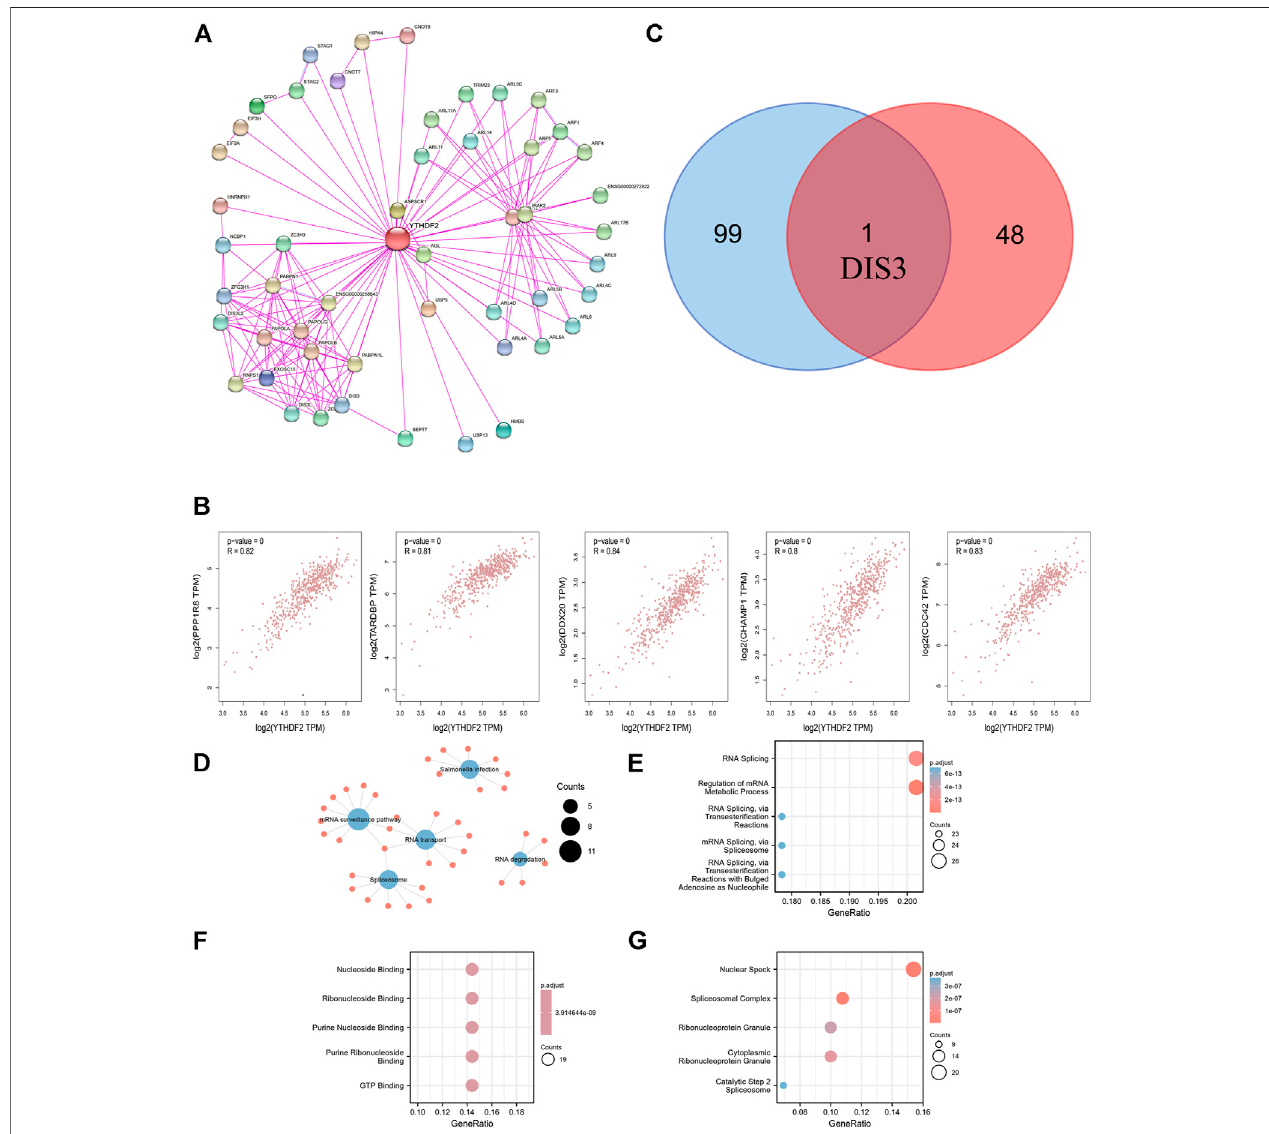
FIGURE 7 | YTHDF2-related gene enrichment analysis and GO and KEGG analysis. (A) The available experimentally determined YTHDF2-binding proteins using the STRING tool. (B) The expression correlation between YTHDF2 and selected targeting genes, including PPP1R8, TARDBP, DDX20, CHAMP1 and CDC42. (C) An intersection analysis of the-binding and correlated genes was conducted. (D) KEGG pathway analysis. (E) Biological processes. (F) Molecular functions. (G) Cellular components.